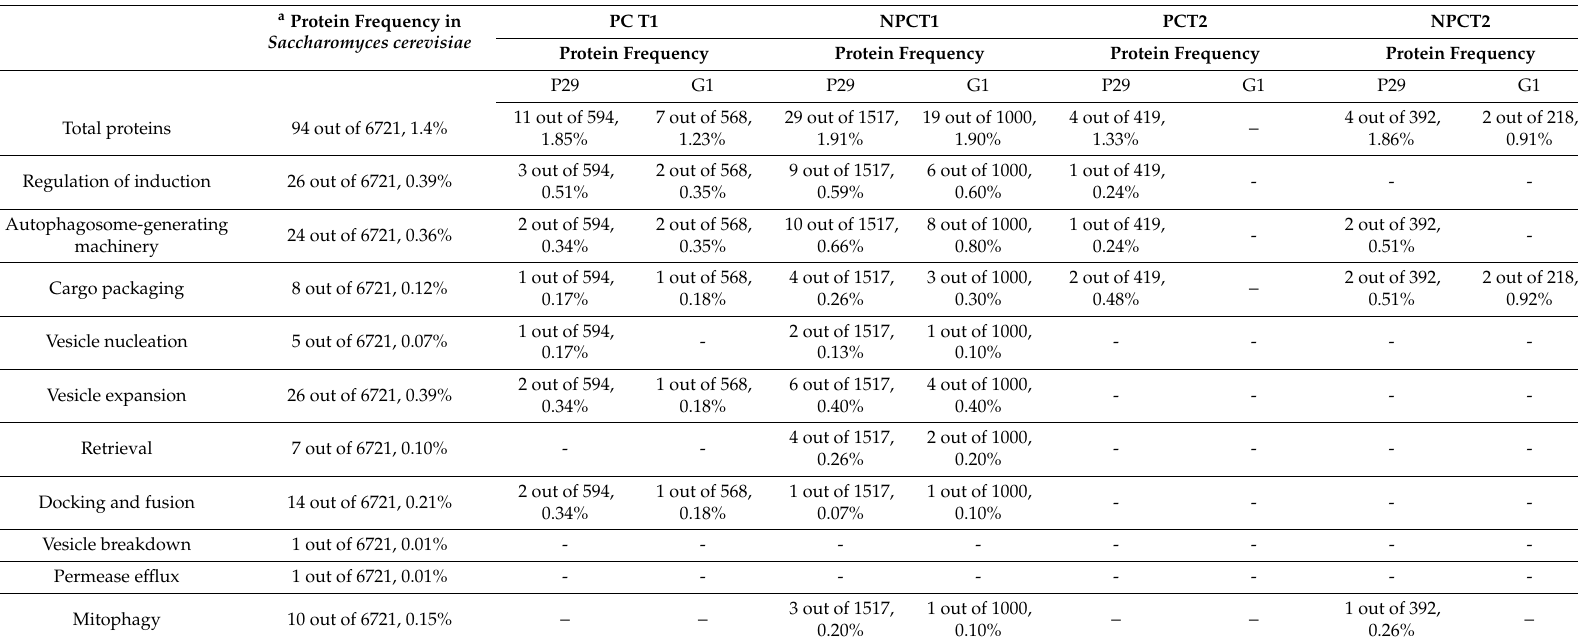
Table 1. Frequency of the autophagy-related proteins identified in both yeast strains ( S. cerevisiae P29 and G1) under PC (pressure condition) and NPC (non-pressure condition), at the middle of the secondary fermentation (T1) and one month after it